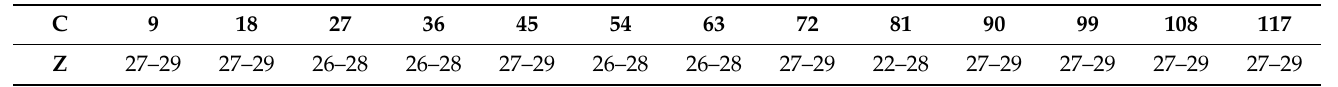
C, cycles per piece; Z, Effort S